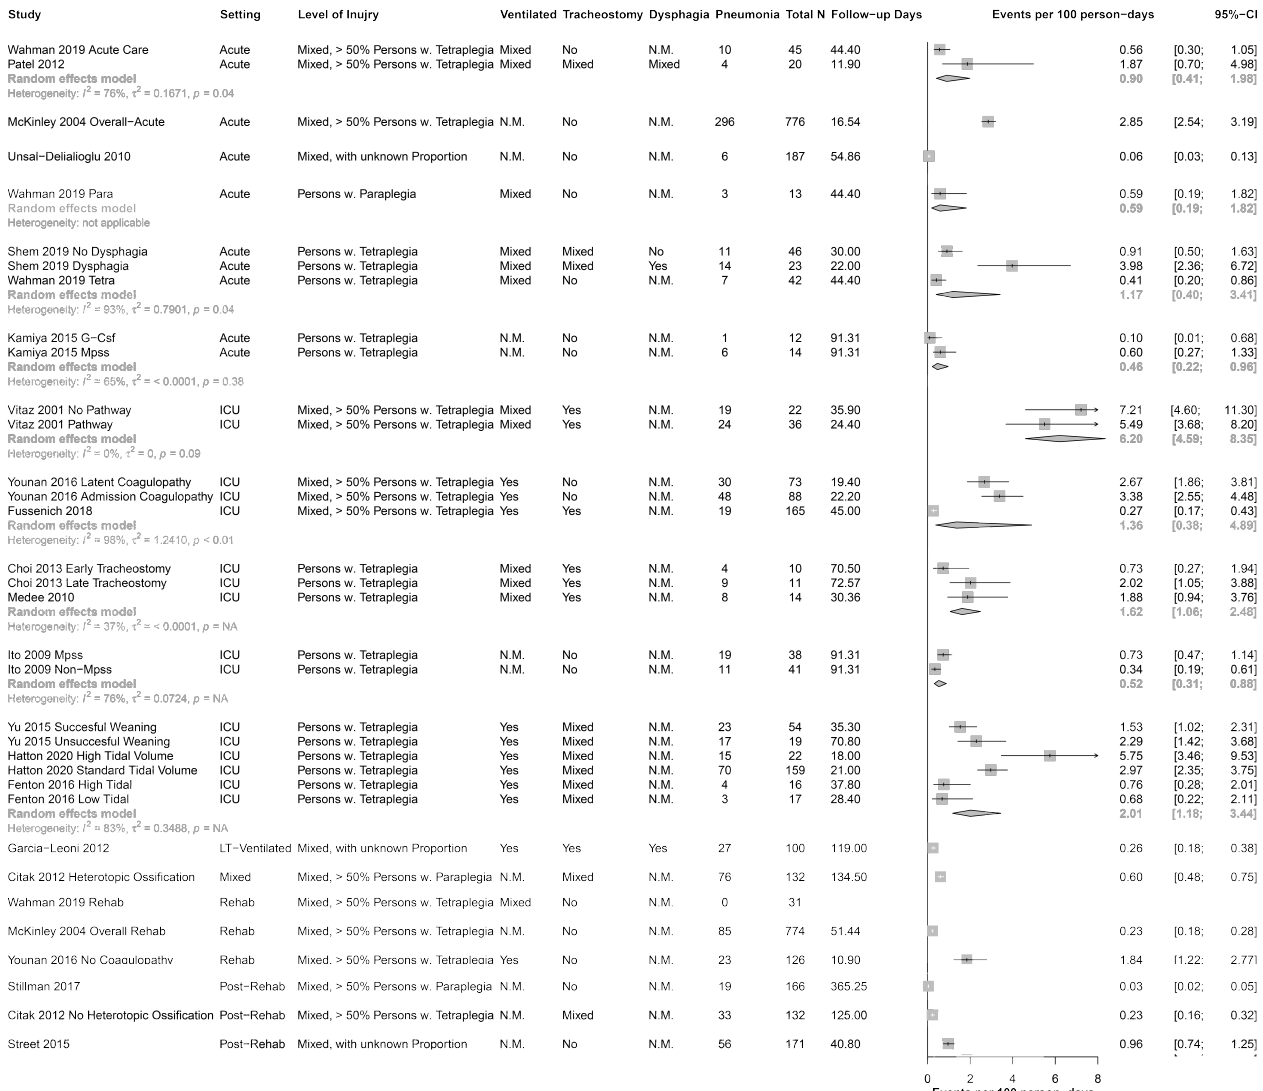
Figure 2. Forest Plot of all included study samples, without pooled results. CI = confidence interval; Fup, Follow up; G-Csf, granulocyte colonystimulating factor; ICU, Intensive Care Unit; LT-Ventilated, long-term ventilated; MPSS, high-dose methylprednisolone sodium succinate; n.m., not mentioned; Para, paraplegia; Rehab, rehabilitation; Tetra, tetraplegia; Ventilation, mechanical